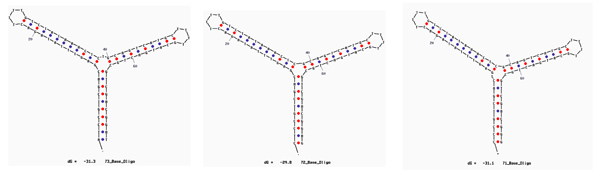
Shown are Y-shaped aptamers that have shown they have capture states with the desired blockaded toggling.